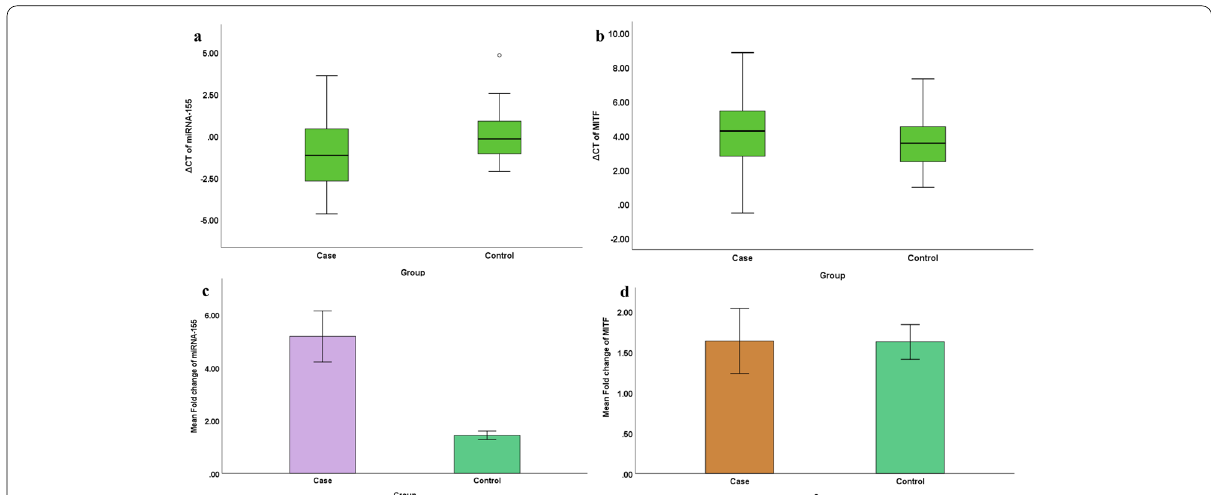
Fig. 1 a Box and whisker plot showing ΔCT value of miRNA-155 in groups I and II. b Box and whisker plot showing ΔCT value of MITF gene expression in groups I and II. c Bar chart showing the mean fold change in miRNA-155 expression in groups I and II. d Bar chart showing the mean fold change in MITF gene expression in groups I and II